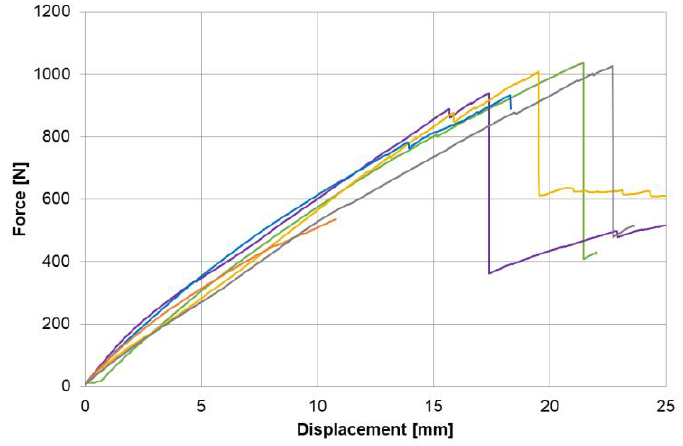
Figure 15. Results of the mechanical two-point limb bending test.